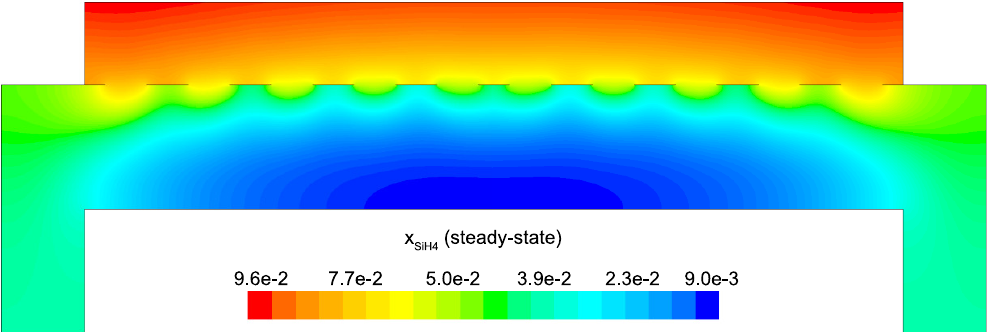
Figure 14. Steady-state profile of x SiH